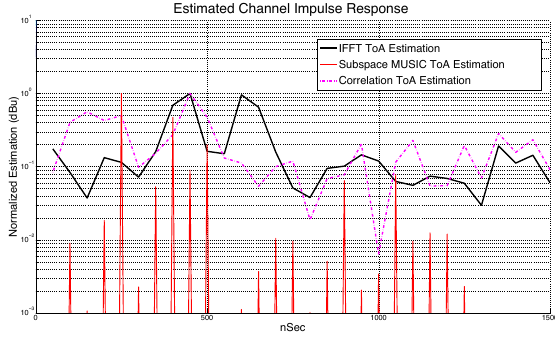
Figure 10. Performance in estimation of ( α i , τ i ) for